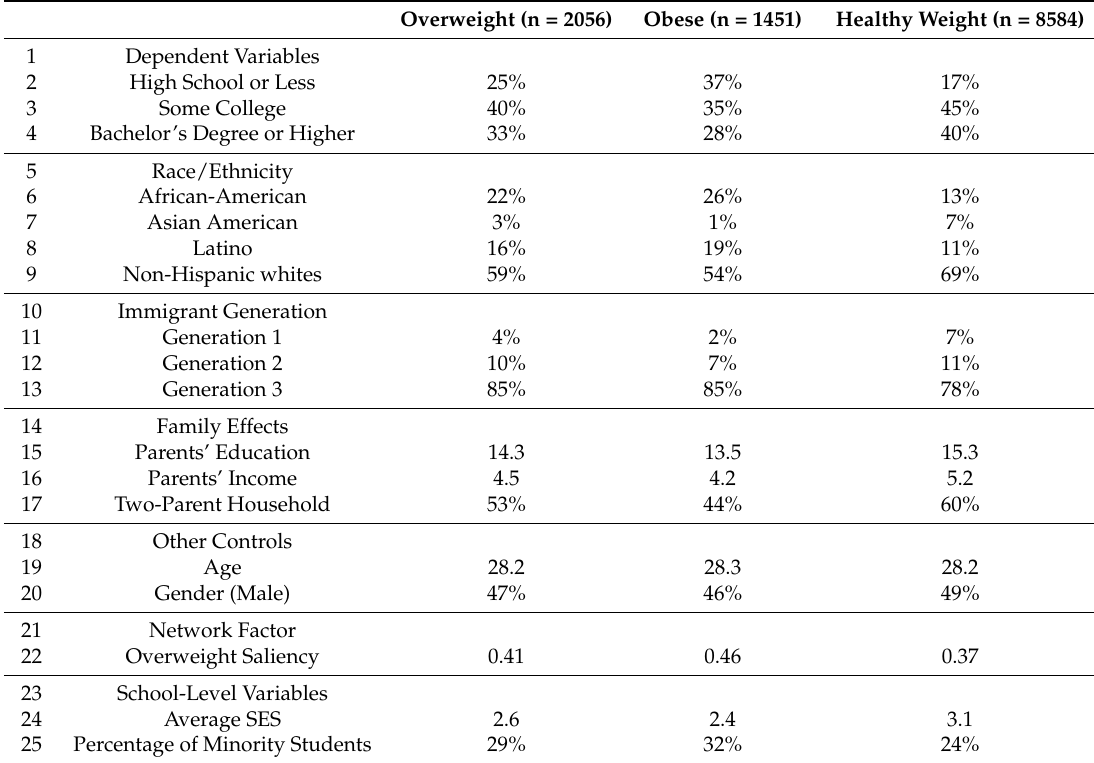
Table 1. Weighted means (or percentages) and standard deviations of study variables by overweight/obesity status. SES: socio-economic